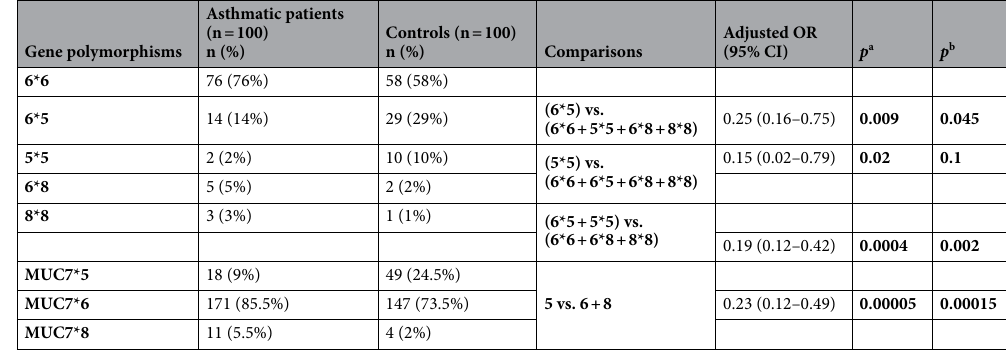
Table 2. Genotypes and allelic frequencies of MUC7 VNTR in asthmatic patients and controls. Data are presented as numbers with percentages. p a : p -value was calculated by Chi square test after adjusting for sex and age. p b : p -value after Bonferroni correction. Bonferroni p -value was calculated as: original p -value * number of comparatives; number of comparatives was 5 for genotypes and 3 for alleles. n number, CI confidence interval, OR odds ratio; p ≤ 0.05 is significant.